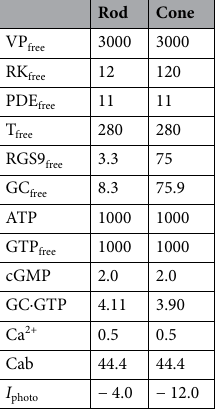
Table 4. Initial set of time-dependent variables.